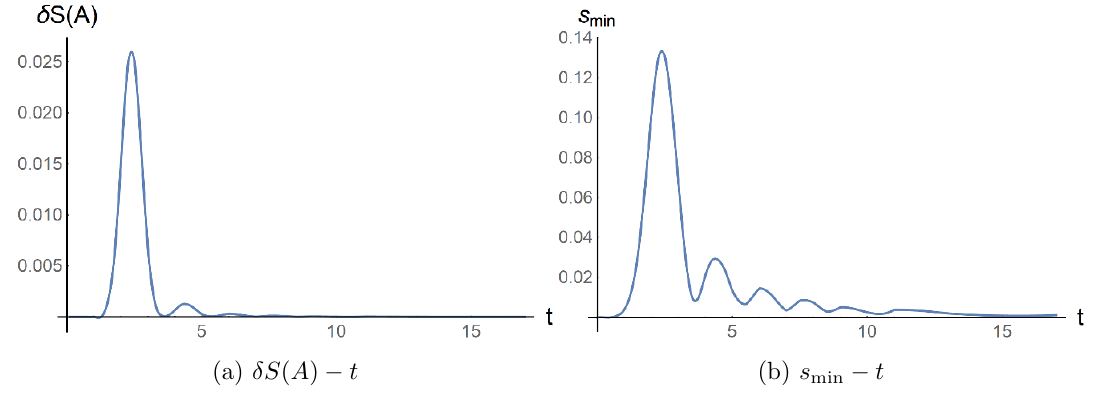
Figure 16. In the plots, m = 1 = 10, L = 202, and j A j = 6, j R j = 10, j A \ R j = 3. (a) (cid:14)S ( A ) (cid:0) t curve. (b) s min (cid:0) t curve.